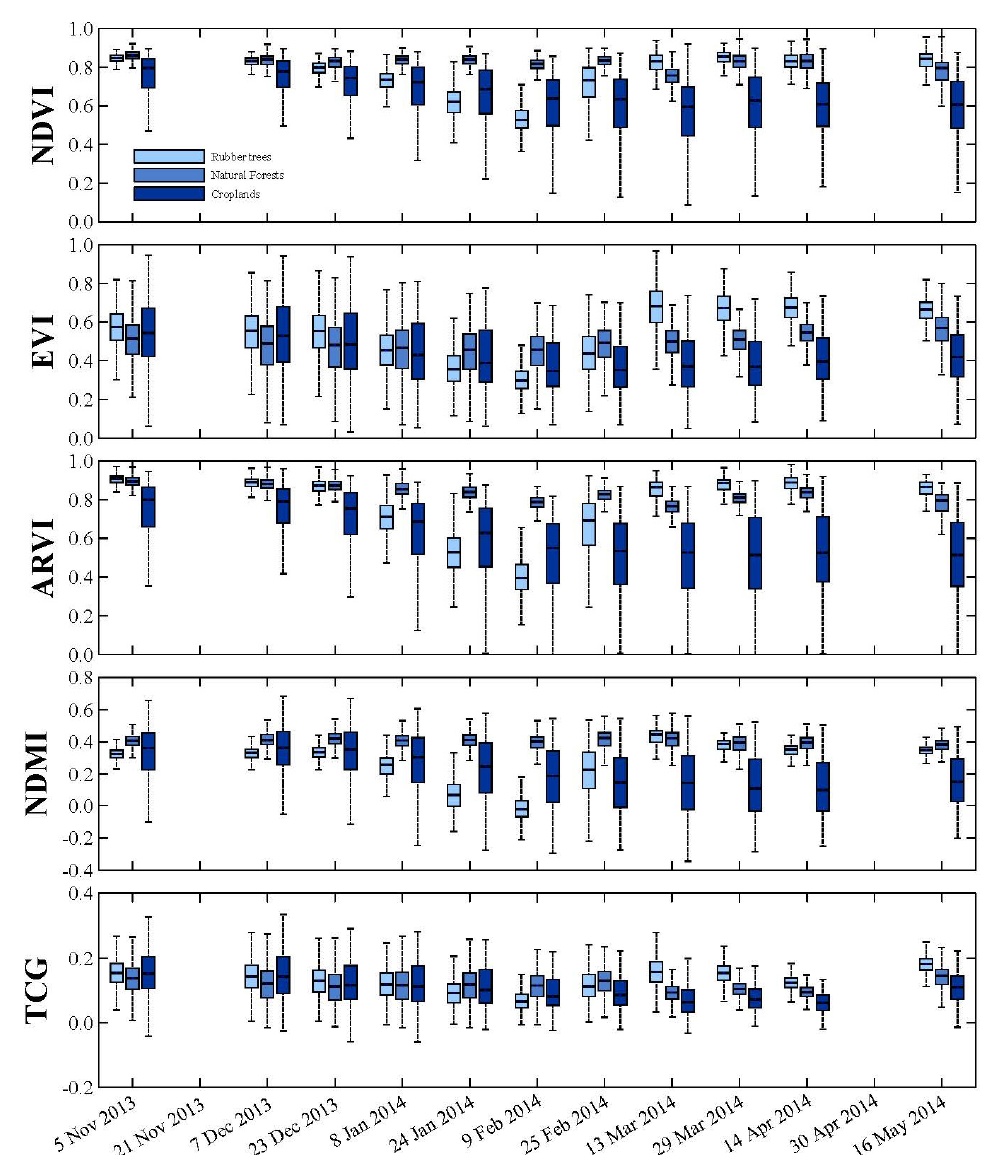
Figure 2. The temporal profiles of the Landsat 8 OLI NDVI, EVI, ARVI, NDMI, and TCG time series for the rubber plantations, natural forests and croplands. Random samples of 2000 pixels were individually extracted from 134 polygons of interest (POIs) for the rubber plantations, 110 POIs for the natural forests and 136 POIs for the croplands. The boxplot depicts the median (the central horizontal line), the 25th and 75th percentiles (the edges of the box) and the most extreme data points (the whiskers). Rubber plantations present two unique phenology stages: defoliation (the long light yellow column) and foliation (the long light green